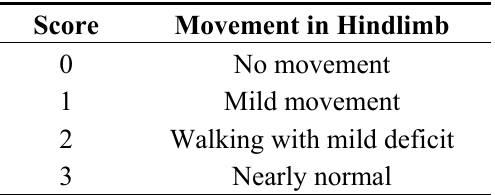
Figure 3. Flat runway with S.D. <